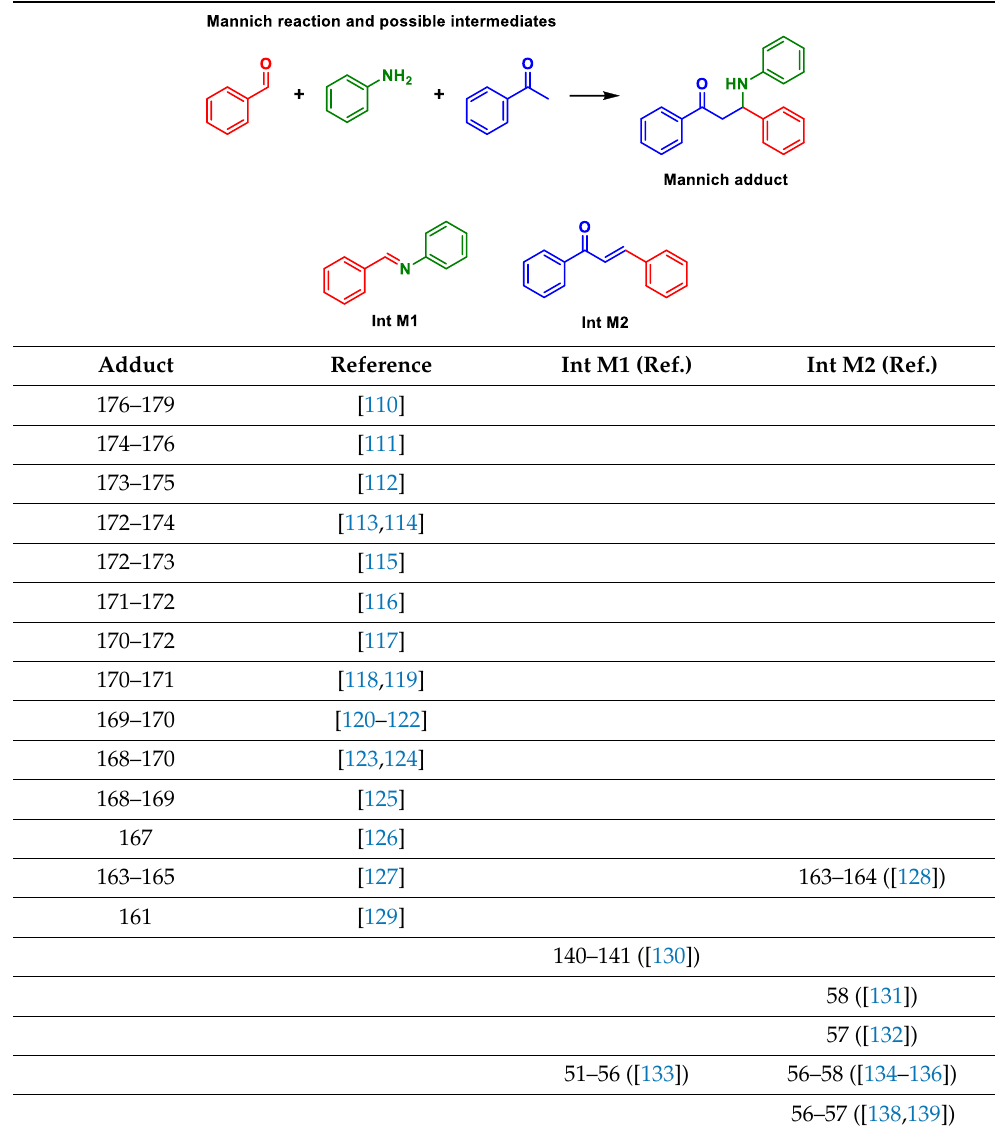
Table 3. Reported mps (°C) for the Mannich MCR and its proposed intermediates.